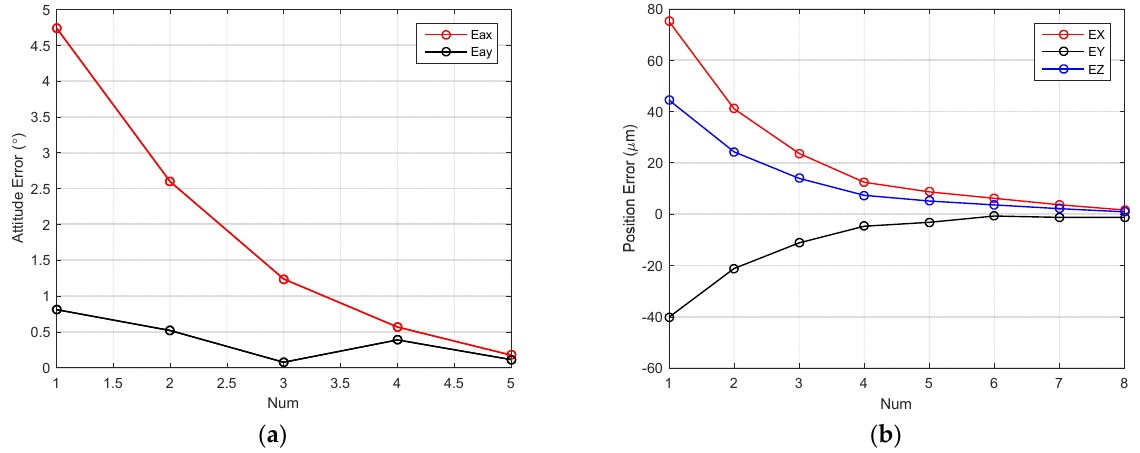
Figure 9. Attitude and position control error: ( a ) attitude error in alignment process; ( b ) position error in alignment process.